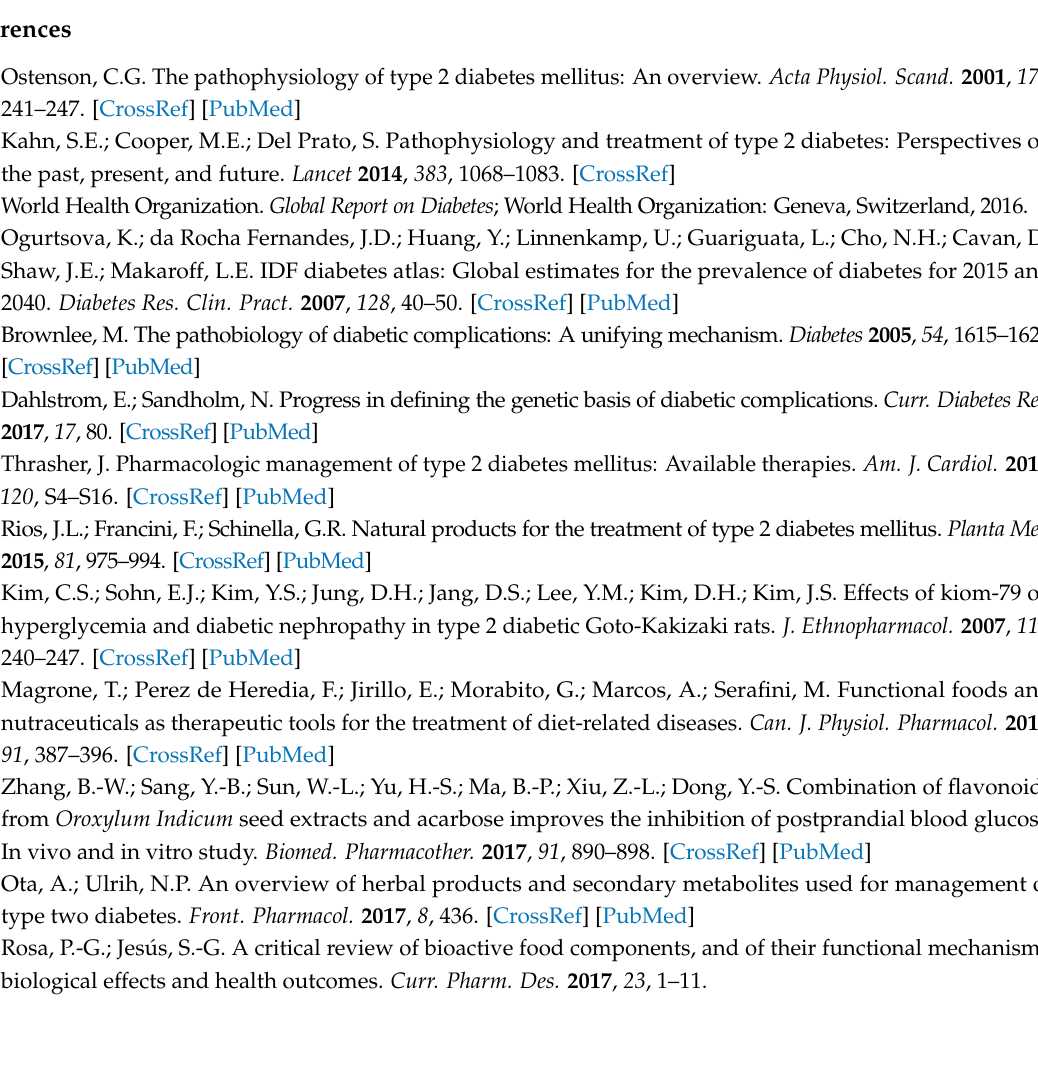
in GK and W rats, Table S2, Effect on hematological and biochemical parameters of male Wistar rats after 28 days of AC treatment, Figure S1, Effect on body weights of Wistar rats after 28 days of AC treatment, Figure S2, Effect of AC long-term treatment (20 days) on body weights, Figure S3, Cytotoxic effect of AC on W pancreatic islets, Figure S4, The AC effect is not mediated by ATP-dependent potassium channels, Figure S5, AC effect on insulin secretion was comparable with the effect of